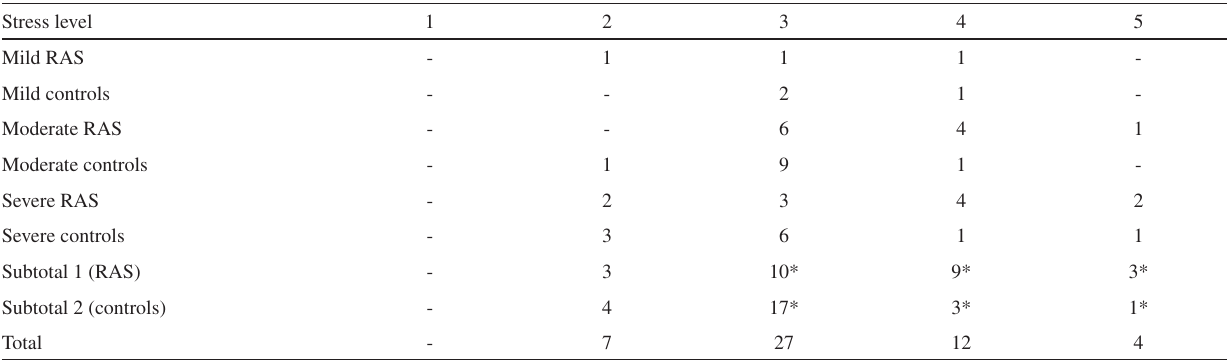
Table 1 - Distribution of patients and controls according to general stress level and RAS severity Stress